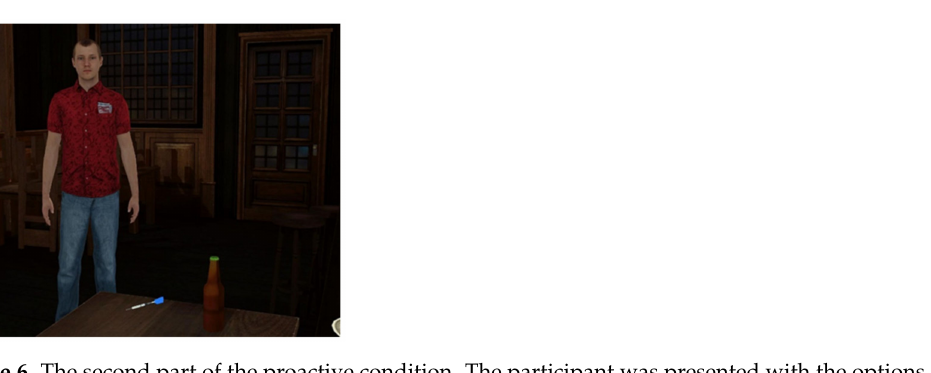
Figure 6. The second part of the proactive condition. The participant was presented with the options to either pick up the dart arrow and play a game, pick up the bottle and start hitting the avatar, or engage in a fistfight with the